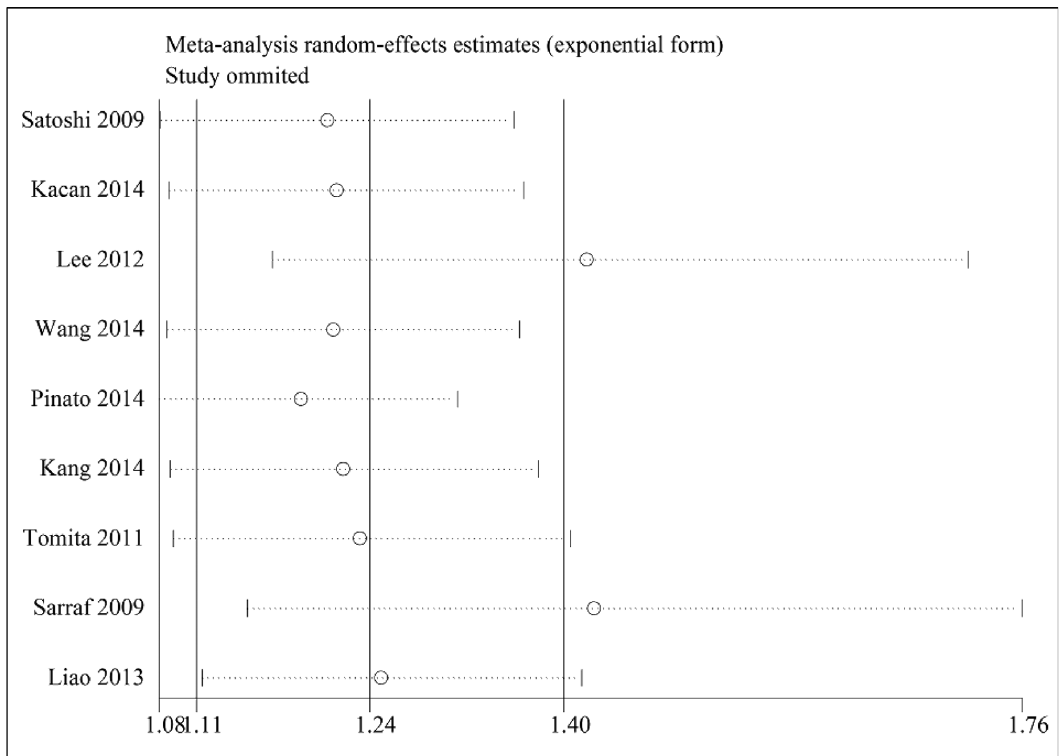
Figure 4 - Effect of multivariate studies on the pooled HR for the NLR and OS of patients.